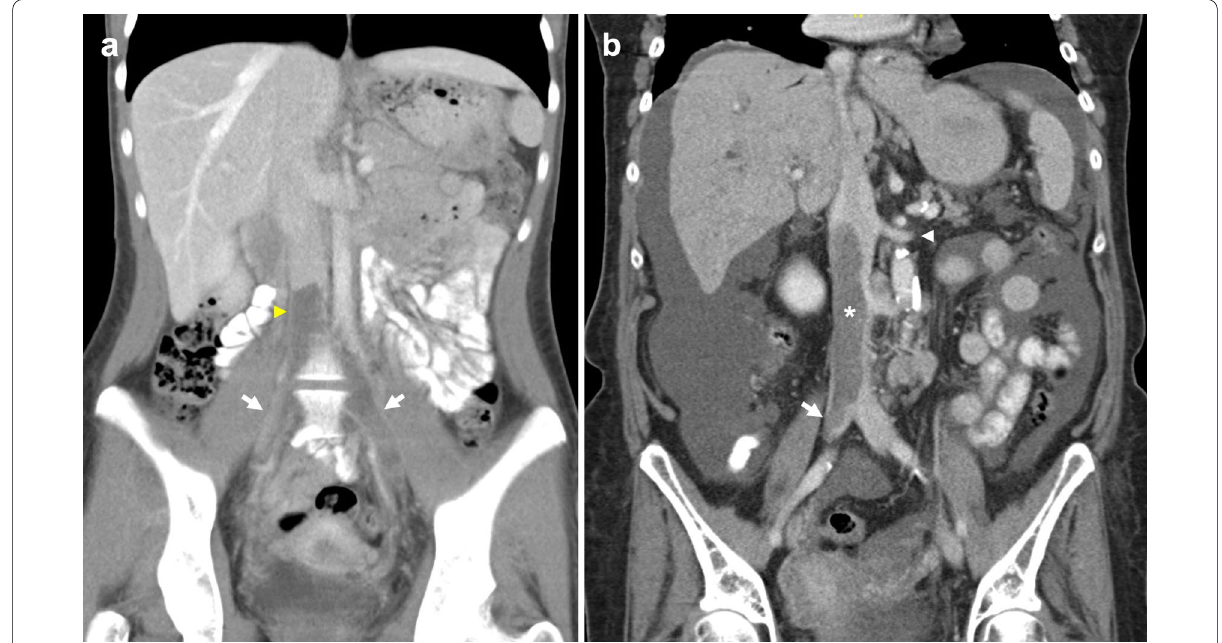
Fig. 22 IVC bland thrombosis. a A 20-year-old woman presented with an oedematous left leg and lower back pain in the context of smoking, regular oral contraceptive use and previous DVT. Contrast-enhanced coronal CT shows a non-enhancing filling defect in the infrarenal cava (arrowhead) that propagates into bilateral common iliac veins (arrows). Mild intra-abdominal fat stranding is likely secondary to thrombosis-related oedema. Thrombophilia screen was negative, and there was no evidence of malignancy or venous compression on a CT scan of the chest, abdomen and pelvis. b A 75-year-old woman presented with a left above knee DVT on a background of cholangiocarcinoma with metastases to the liver and left adnexa. Contrast-enhanced coronal CT demonstrates a partially occlusive non-enhancing inferior vena cava thrombus (asterisk) extending superiorly to the level of the left renal vein (arrowhead), and to the right common iliac vein (arrow) caudally